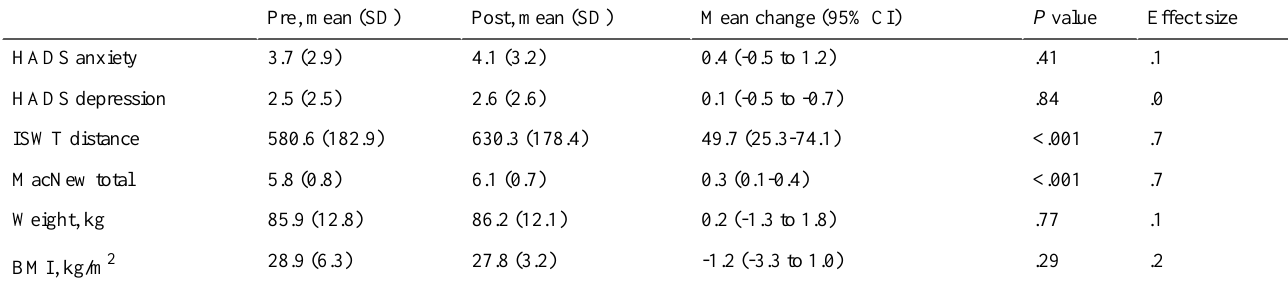
Table 2. Changes in exercise performance and health status (n=33).